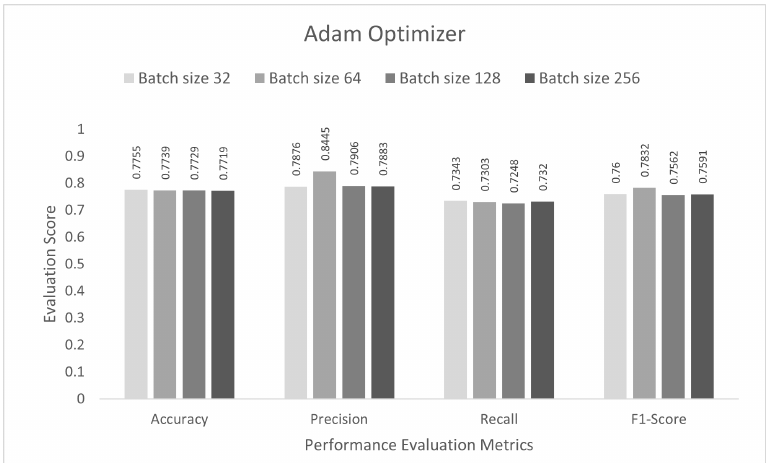
Figure 9. Adam optimizer for multi-class sub-category classification scenario.